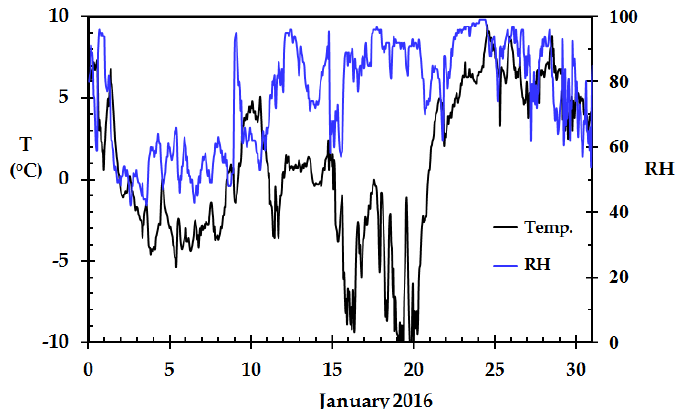
Figure 4. Recorded temperature and relative humidity at the local meteorological station (Haugesund airport), January 2016.